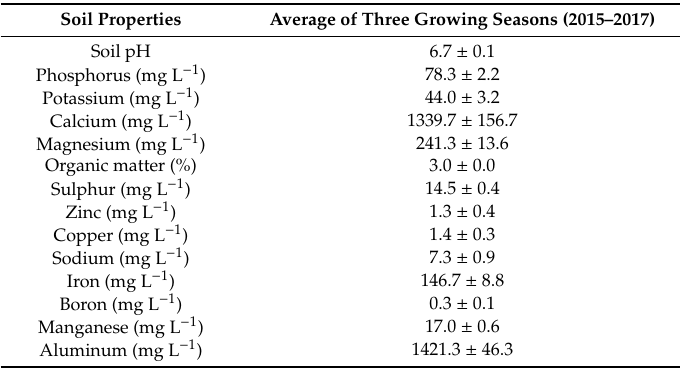
Table 1. Basic soil properties of experimental site during three growing seasons. Values are means ± standard error for three